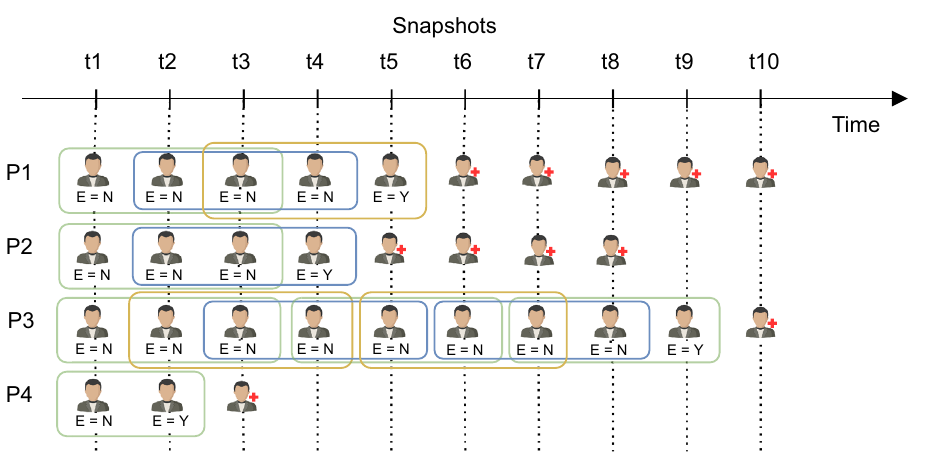
Figure 8. Example on the computation of snapshots with maximum length min ( L , nP ) , in this case, L = 3 and nP is represented by the number of snapshots (where the patient was not in a critical state) availabe for each patient. P4 has only 2 ( nP = 2 ) snapshots before the critical state, and only one set with these 2 snapshots was